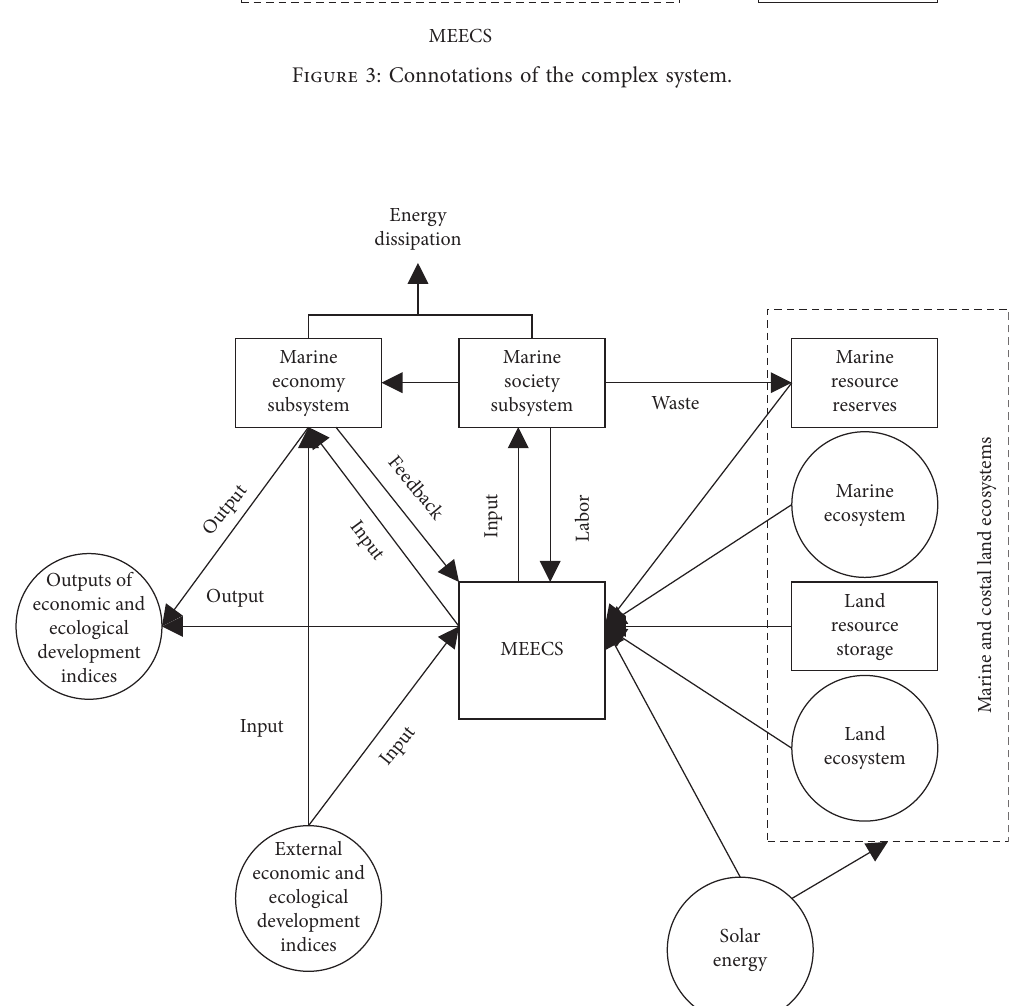
Figure 4: Input-output energy flows of the complex